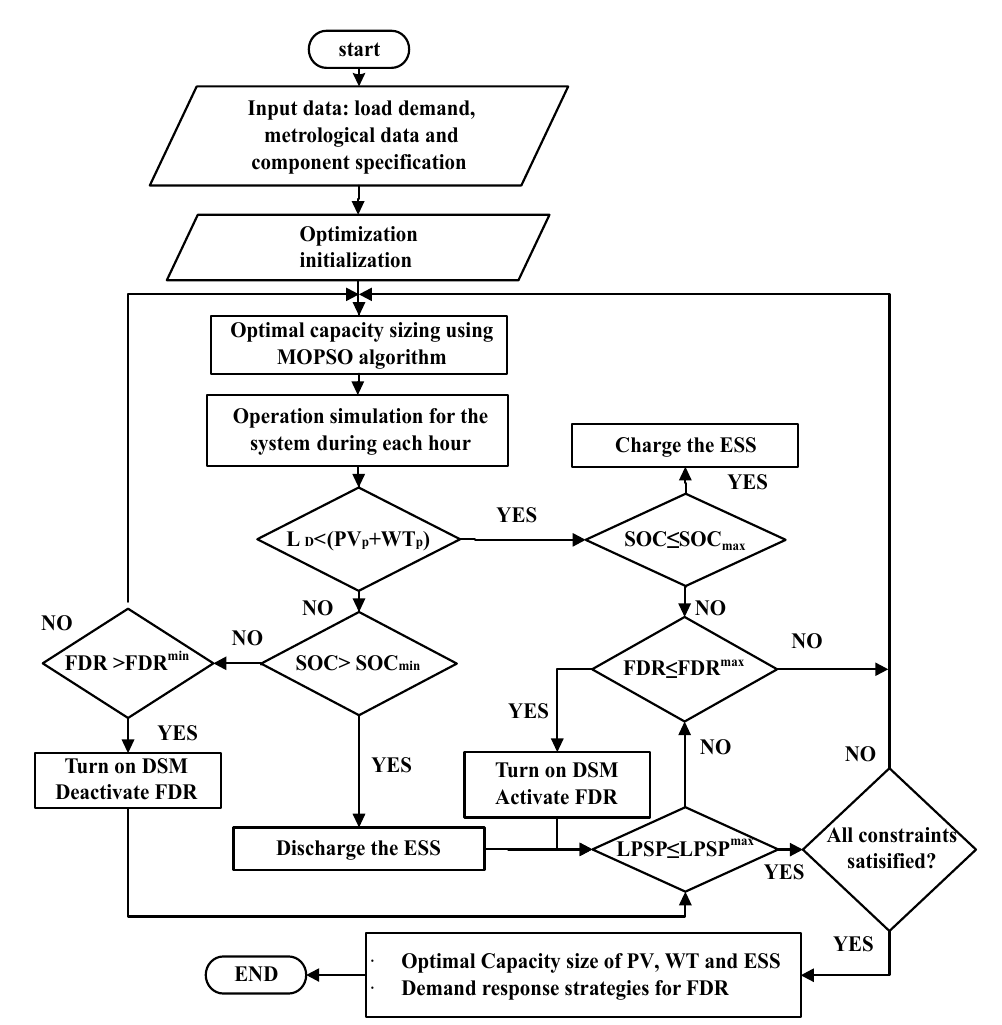
Figure 3. Flowchart for the proposed integrated system planning